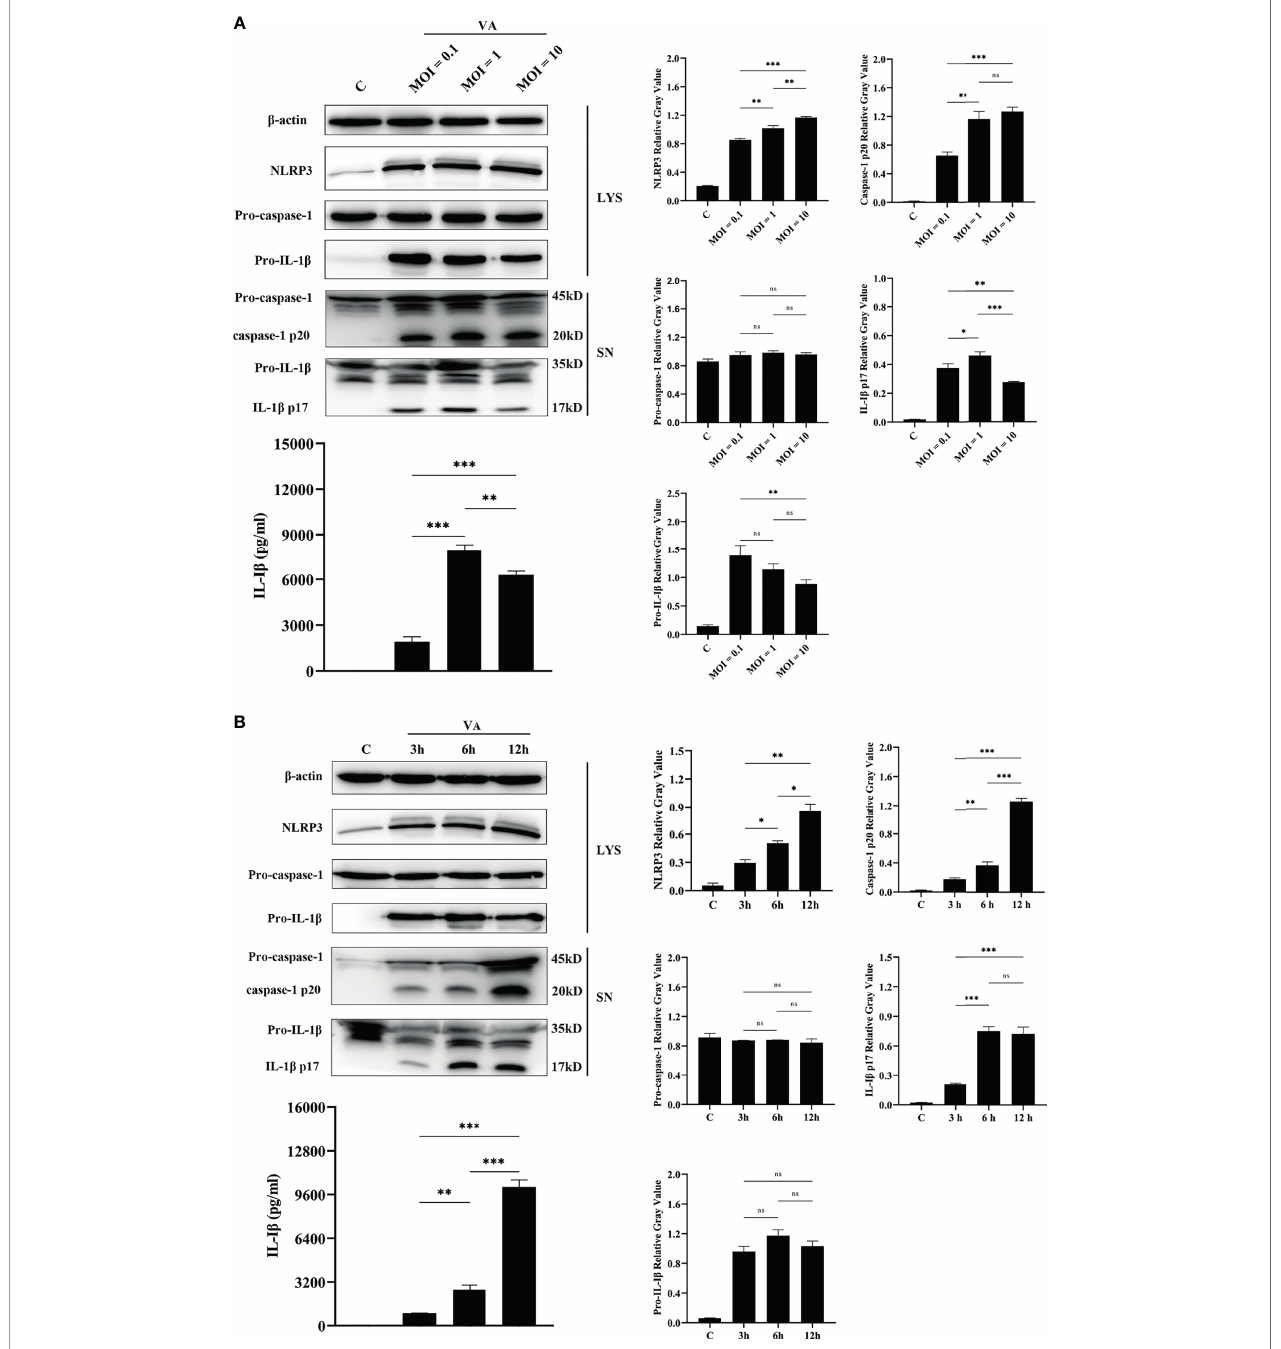
FIGURE 4 | The activation of the NLRP3 in fl ammasome was dose-dependent and time-dependent. (A) Dose-dependent (MOI = 0.1, 1, and 10) assay of macrophages infected with V. alginolyticus for 12 h The protein expression levels of NLRP3, pro-caspase-1, caspase-1, pro-IL-1 b , and IL-1 b were con fi rmed by Western blotting, and IL-1 b protein expression was also detected by ELISA. (B) Time course (3, 6, and 12 h) assay of macrophages infected with V. alginolyticus at MOI of 1. The protein expression levels of NLRP3, pro-caspase-1, caspase-1, pro-IL-1 b , and IL-1 b were con fi rmed by Western blotting, and the mature IL-1 b released into supernatant was detected by ELISA. Data from ELISA and Western blotting gray value results were representative of at least three repetitive experiments. ns, not signi fi cance, * p < 0.05, ** p < 0.01, and *** p <